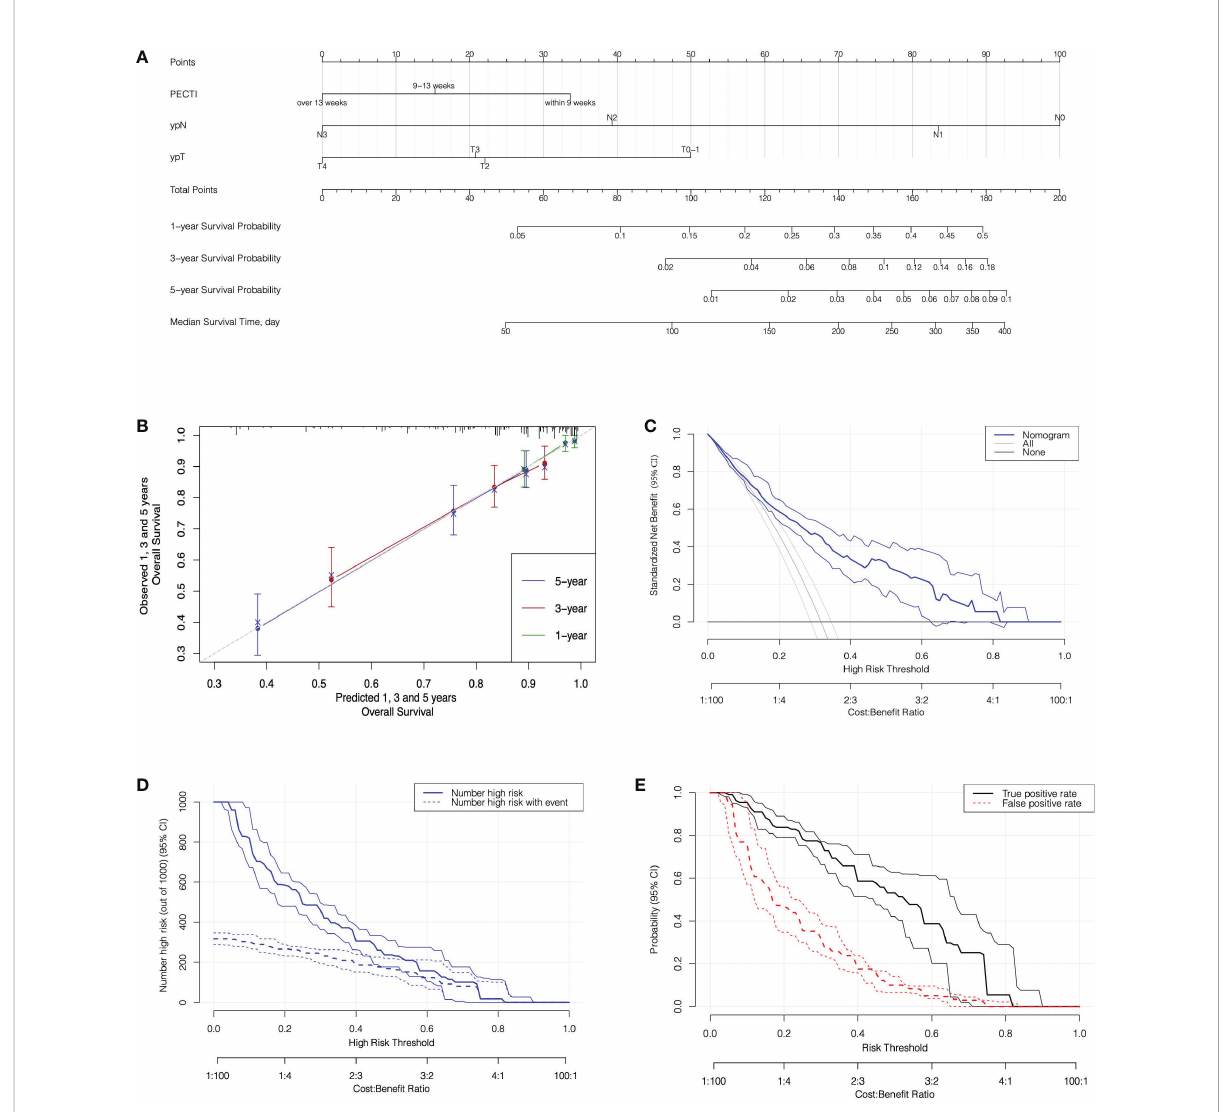
FIGURE 7 The nomogram prediction model with calibration and decision analyses. (A) The Nomogram Prediction Model. Points were assigned for PECTI, ypN, and ypT by drawing a line upward from the relevant values to the points line. The sum of the three points plotted on the total points line corresponds to assessments of 1-, 3-, and 5-year overall survival probability and median survival time of patients experiencing perioperative chemotherapy and surgery. (B) The Calibration of Nomogram. The dotted gray line expressed desired nomogram accuracy, and green, red, blue line expressed developed nomogram respectively in 1, 3, and 5 years, closer alignment with the gray line and better prognostic prediction. Crosses mark expressed bias corrected estimates and vertical bars expressed 95% Con fi dence Interval. (C) Decision curves for Nomogram model. Solid transverse line ‘ None ’ meant net bene fi t when all patients were still alive and diagonal straight line in left meant net bene fi t when all patients died. (D) Clinical impact curve for nomogram. Of 1,000 patients, the solid line shows the total number who would be deemed high risk of recurrence or death for each risk threshold, and the dashed line shows how many of those would be true. (E) True and false positive rates as functions of the risk threshold. Bands on all plots denote pointwise 95% CI constructed via bootstrapping. The horizontal axis is labeled in terms of both risk threshold and cost/bene fi t ratio, prompting the correspondence of them. PECTI, perioperative chemotherapy time interval; DCA, decision curve